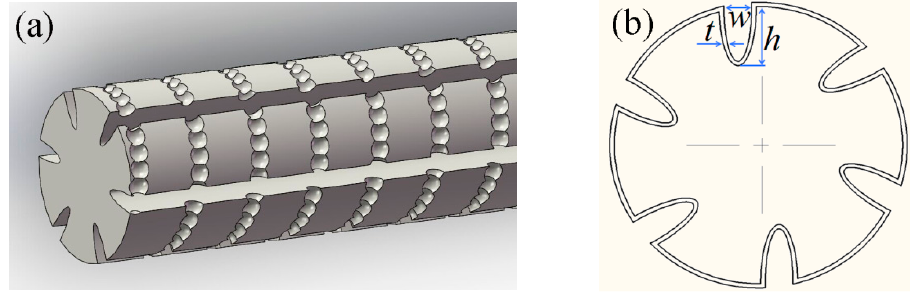
Figure 1. ( a ) Schematic profile diagram of the fiber Bragg grating (FBG) sensor; ( b ) simplified sectional view of the sensor.